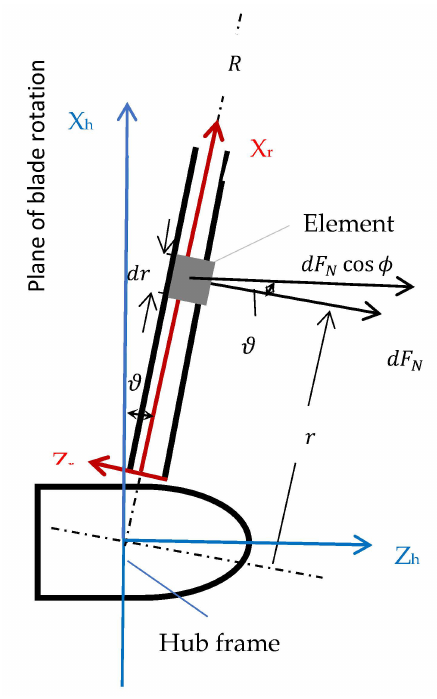
Figure 3. Aerodynamic normal force at a blade